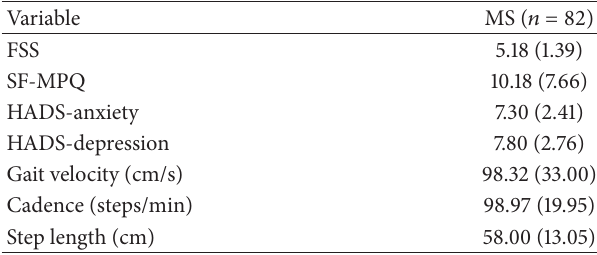
Table 1: Symptomatic and gait characteristics for 82 persons with MS.